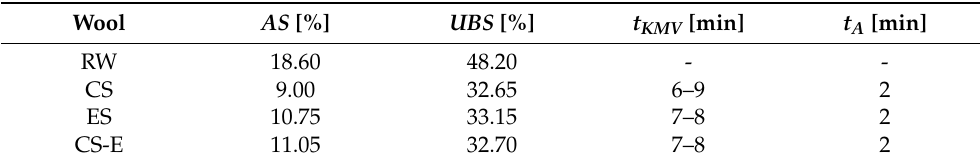
Table 2. The alkali solubility ( AS ), the solubility in urea bisulphite ( UBS ), reaction time in